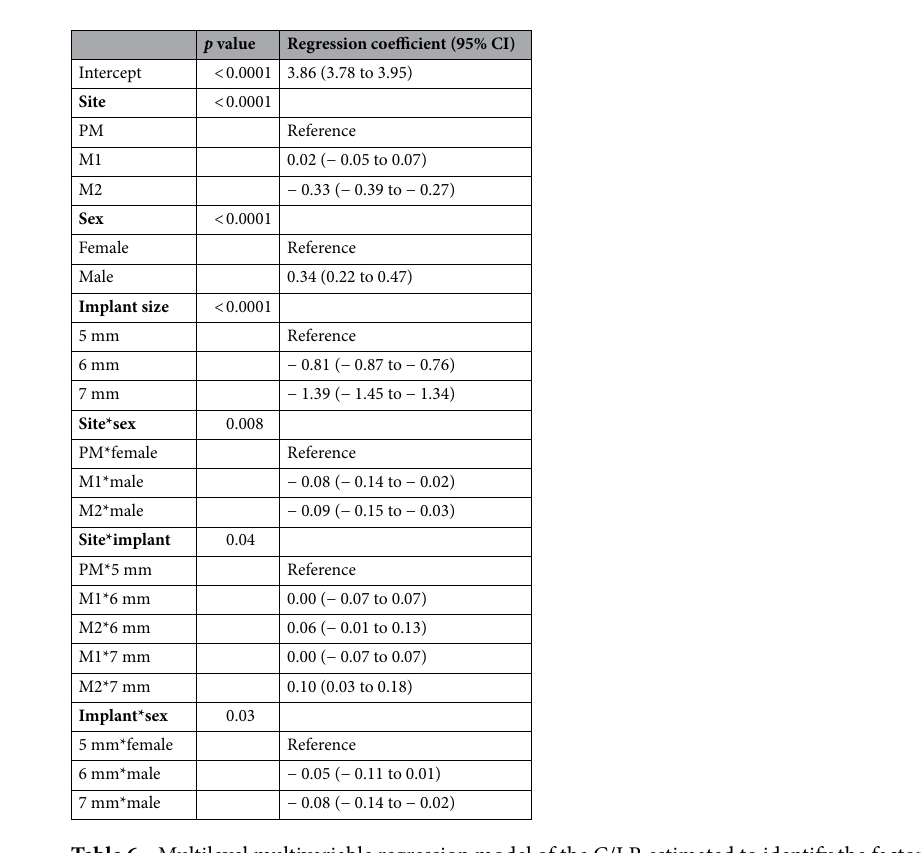
Table 6. Multilevel multivariable regression model of the C/I R estimated to identify the factors associated with the C/I R (sex, site or implant length), including all interactions. PM: second premolar. M1: first molar. M2: second molar. Model selection was done by minimizing the AIC: the 3-way interaction term was removed (AIC from 704 to